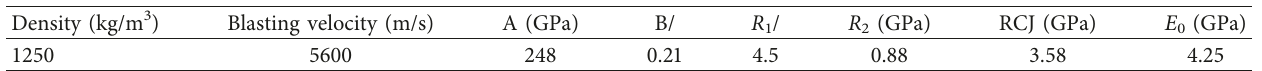
Table 2: Parameters of explosive